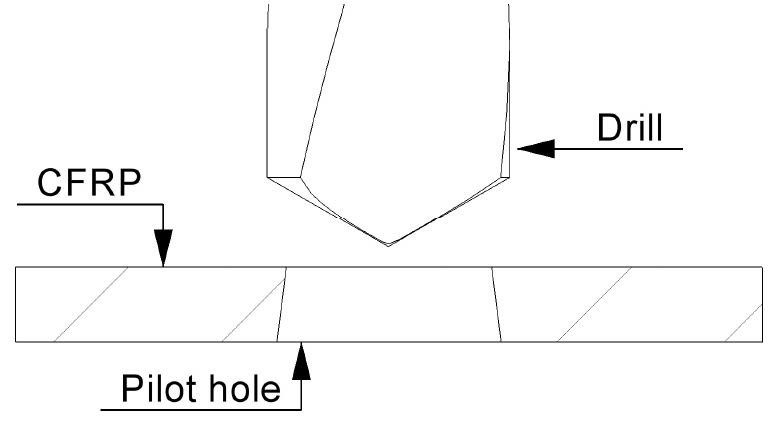
Figure 4. Schematic diagram of mechanical hole finishing process.